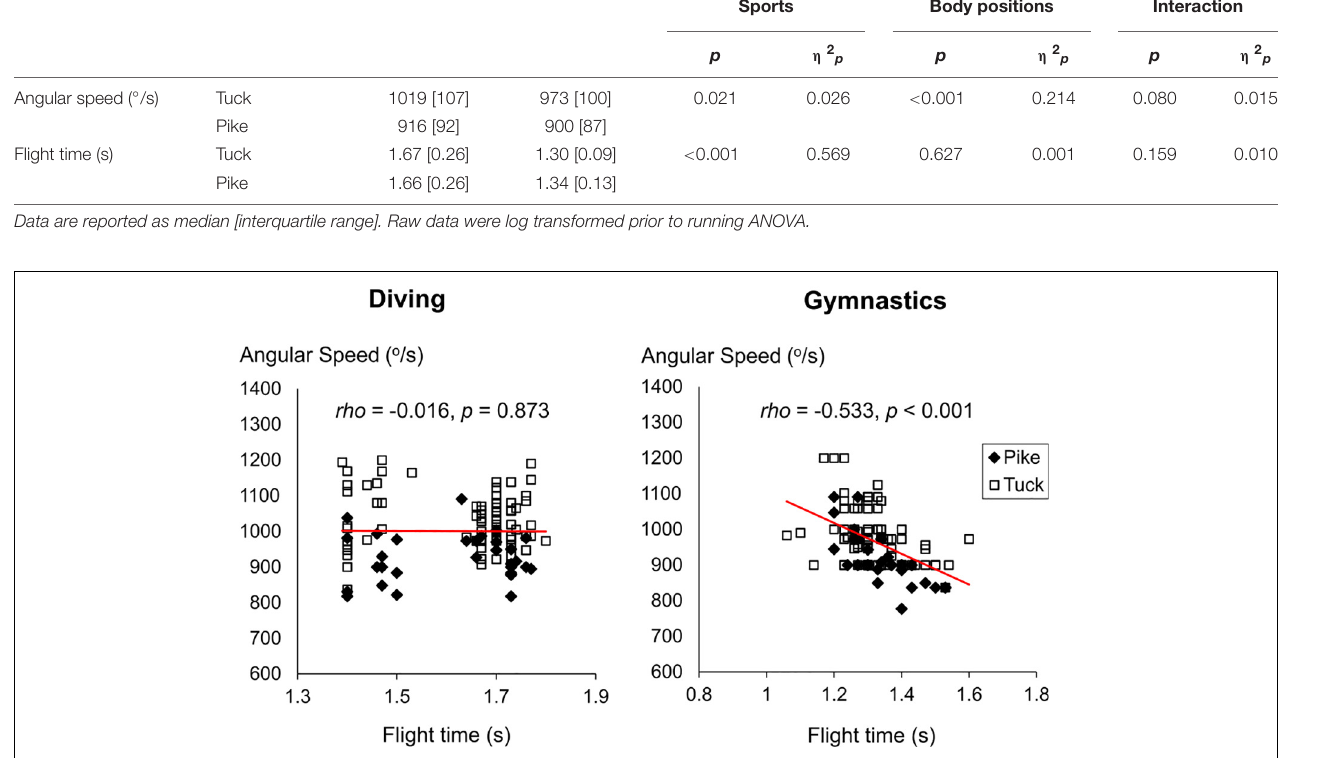
Frontiers in Education |